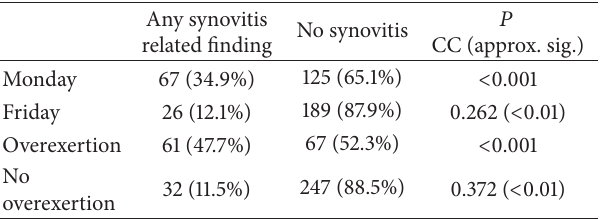
Table 4: Global synovitis proportion among subjects grouped by day of study and self-reported